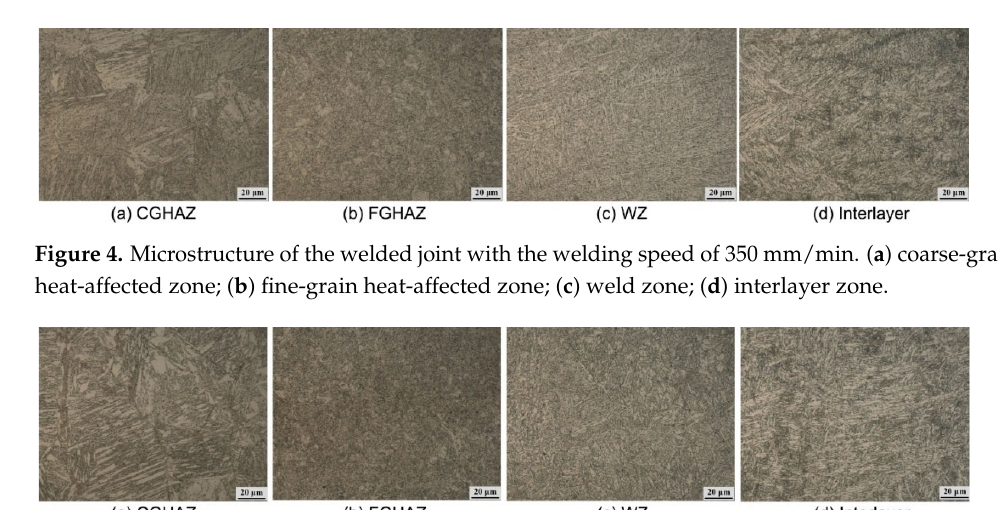
Crystals 2022 , 12 , x FOR PEER REVIEW 5 of 10 Figure 3. Cross ‐ sections of the narrow ‐ gap GMA welded joints under different welding speeds: ( a ) 350 mm/min; ( b ) 300 mm/min; ( c ) 250 mm/min.